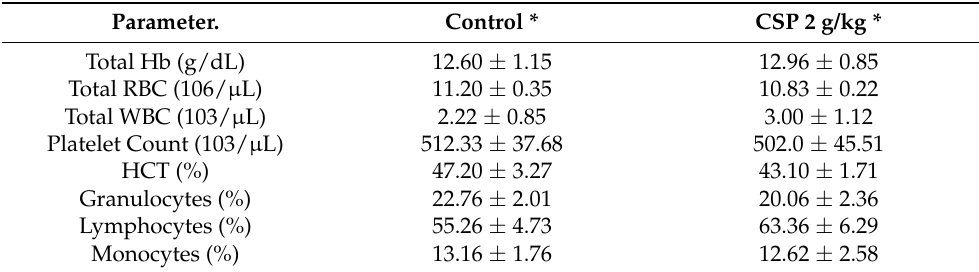
Table 4. Hematological parameters of mice.